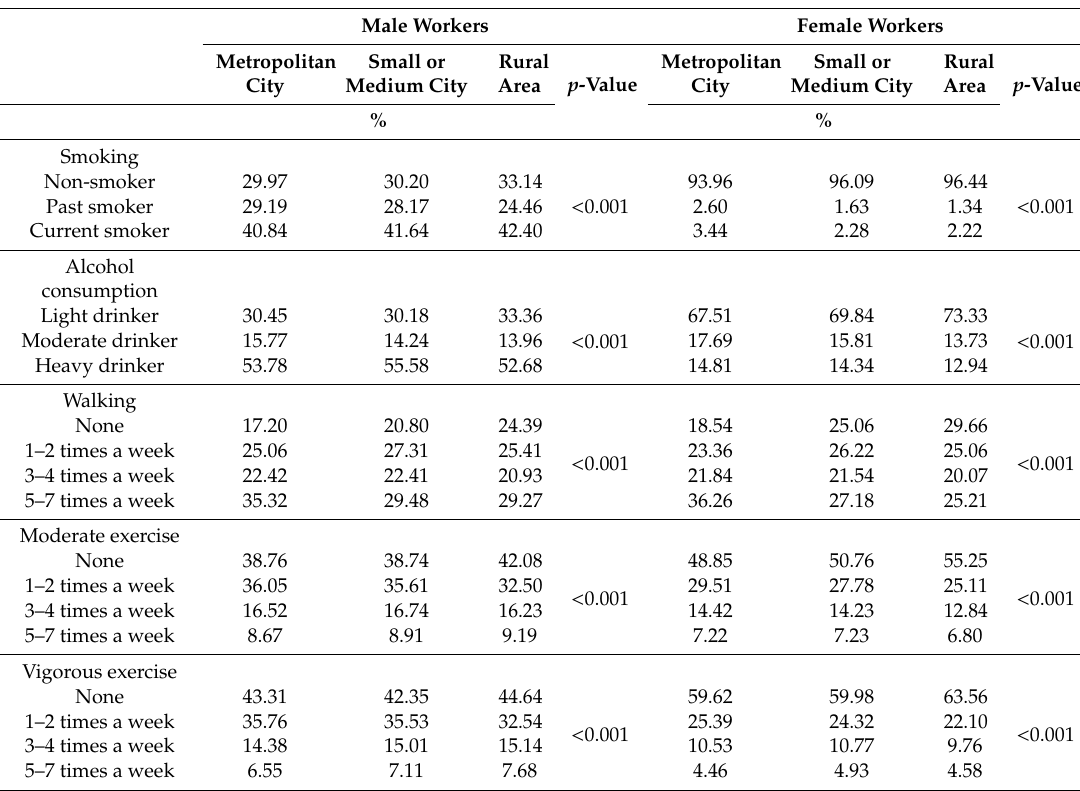
p -values were calculated by cross tabulation analysis (chi-squared test) within each